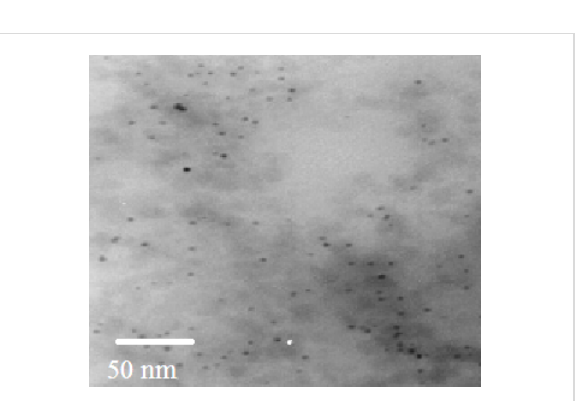
Figure 5: Optical absorbance spectra of composites 54a (1) and 54Au (2).